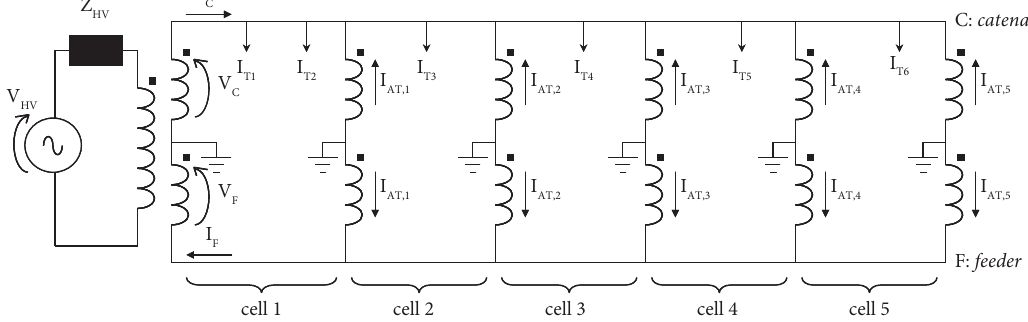
Figure 1: Sketch to illustrate an initial description of 2 × 25kV electric railway